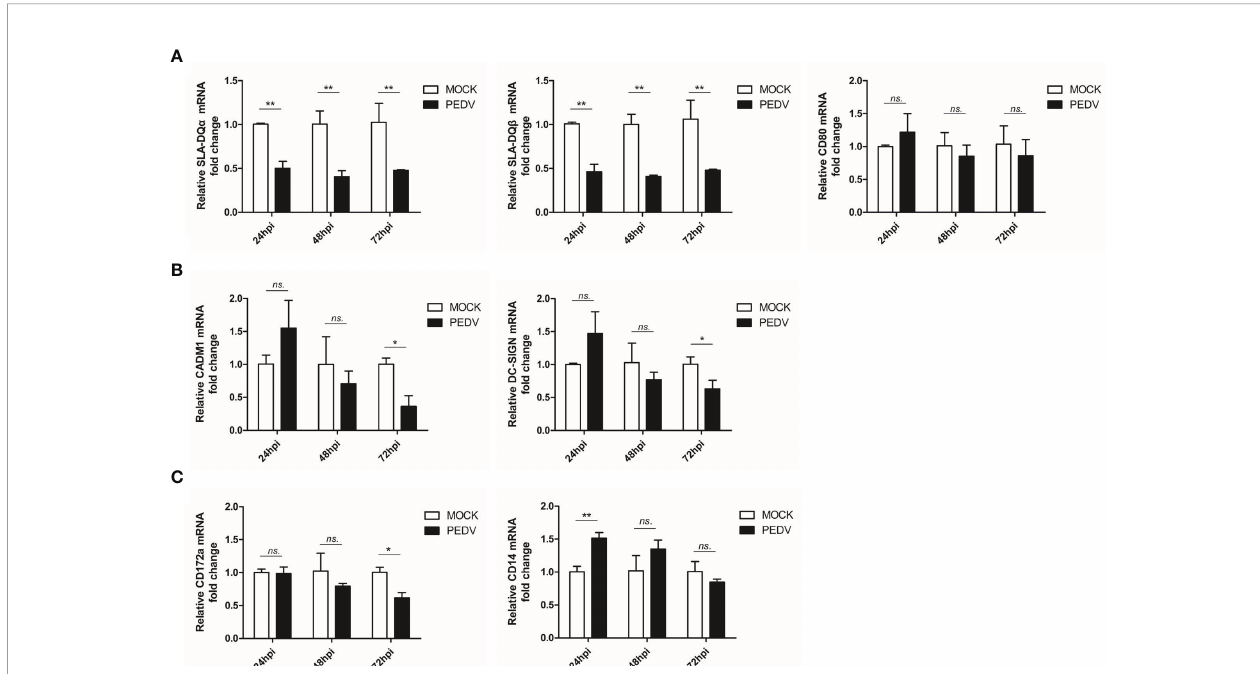
FIGURE 4 | PEDV infection of BM-DCs alternated expression of antigen presentation related molecules (A) BM-DCs were infected by PEDV-KB2013-p120 strain 1 MOI for 24, 48 and 72 hours, then cells were harvested by TRizol for qPCR analysis of SLA-DQ a , SLA-DQ b and CD80. Normal BM-DCs cells without infection harvested at the same time-points were included as control. (B) BM-DCs were infected by PEDV-KB2013-p120 strain 1 MOI for 24, 48 and 72 hours, then cells were harvested by TRizol for qPCR analysis of CDAM1 and DC-SIGN. Normal BM-DCs cells without infection harvested at the same time-points were included as control. (C) BM-DCs were infected by PEDV-KB2013-p120 strain 1 MOI for 24, 48 and 72 hours, then cells were harvested by TRizol for qPCR analysis of CD172a and CD14. Normal BM-DCs cells without infection harvested at the same time-points were included as control. Error bars represent variation from at least three independent experiments. Signi fi cant differences between indicated groups was marked by * P < 0.05; ** P < 0.01. or ns, non signi fi